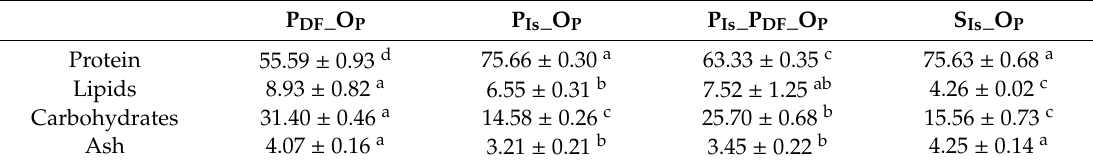
Table 4. Proximate composition of meat analogues (g 100 g − 1 d.m.). P DF _O P : dry-fractionated pea protein and oat protein; P Is _O P : pea protein isolates and oat protein; P DF _P Is _O P : dry-fractionated pea protein, pea protein isolate, and oat protein; S Is _O P : soy isolates and oat protein. P DF _O P P Is _O P P Is _P DF _O P S Is _O P Protein 55.59 ± 0.93